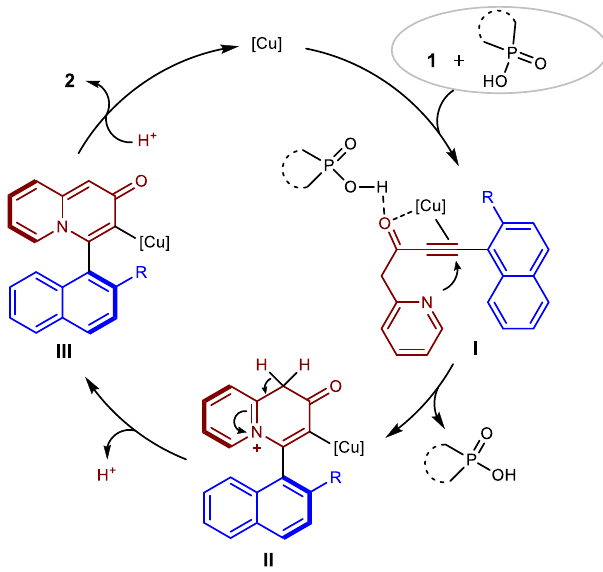
Fig. 6 Proposed catalytic cycle of the reaction. Copper catalyst plays a role in controlling the stereoselectivity, while CPA plays a signi fi cant role in promoting the reactivity of the